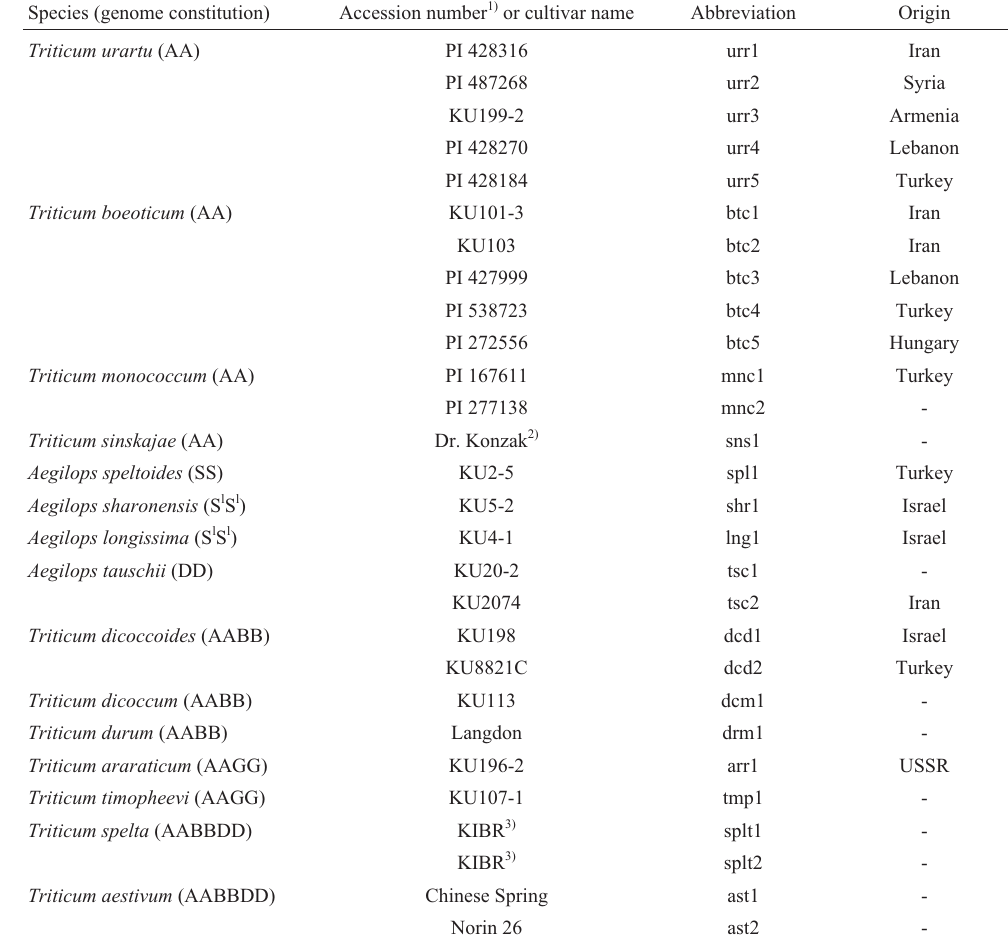
Table 1 - Triticum and Aegilops accessions used in DNA gel blot analysis. Species (genome